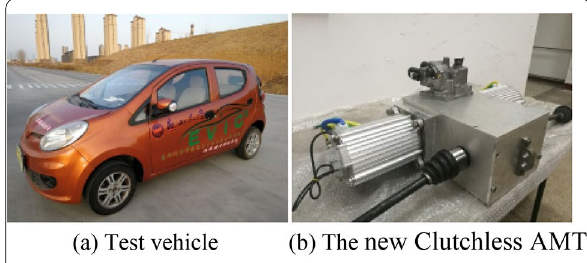
Figure 8 Test vehicle and transmission